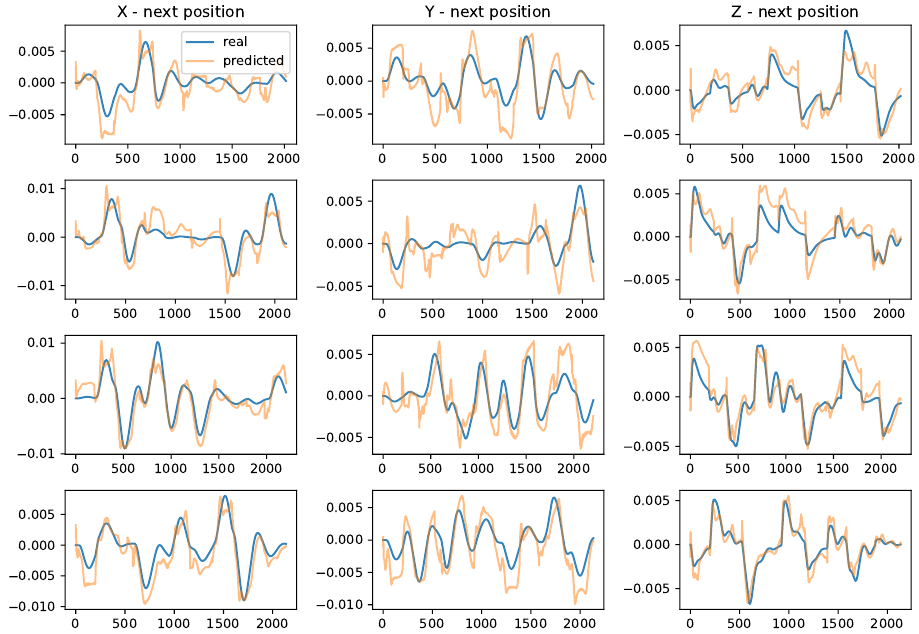
Figure 8. The performance of QFP for the four random trajectories. Each row represents one of the four trajectories, respectively. X-axis is a time step, and Y-axis is a relative position (next position minus current position). These results show that the QFP model predicts the direction of the next position perfectly, whereas there is a little gap in